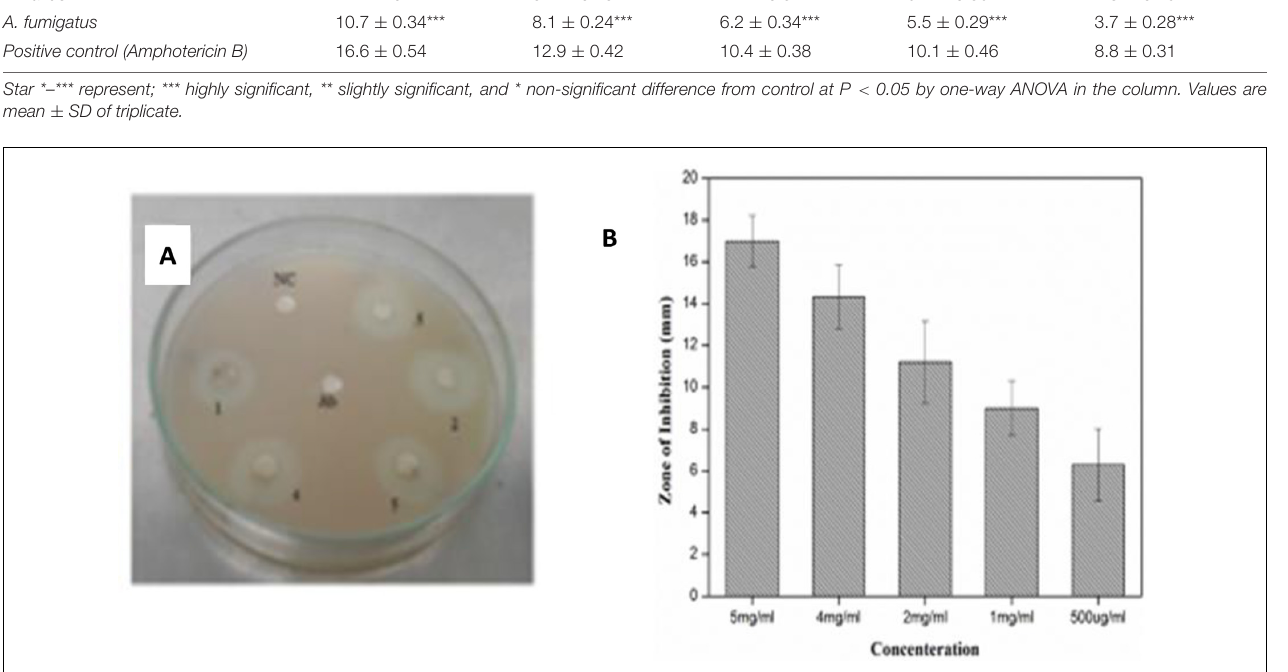
Frontiers in Materials |